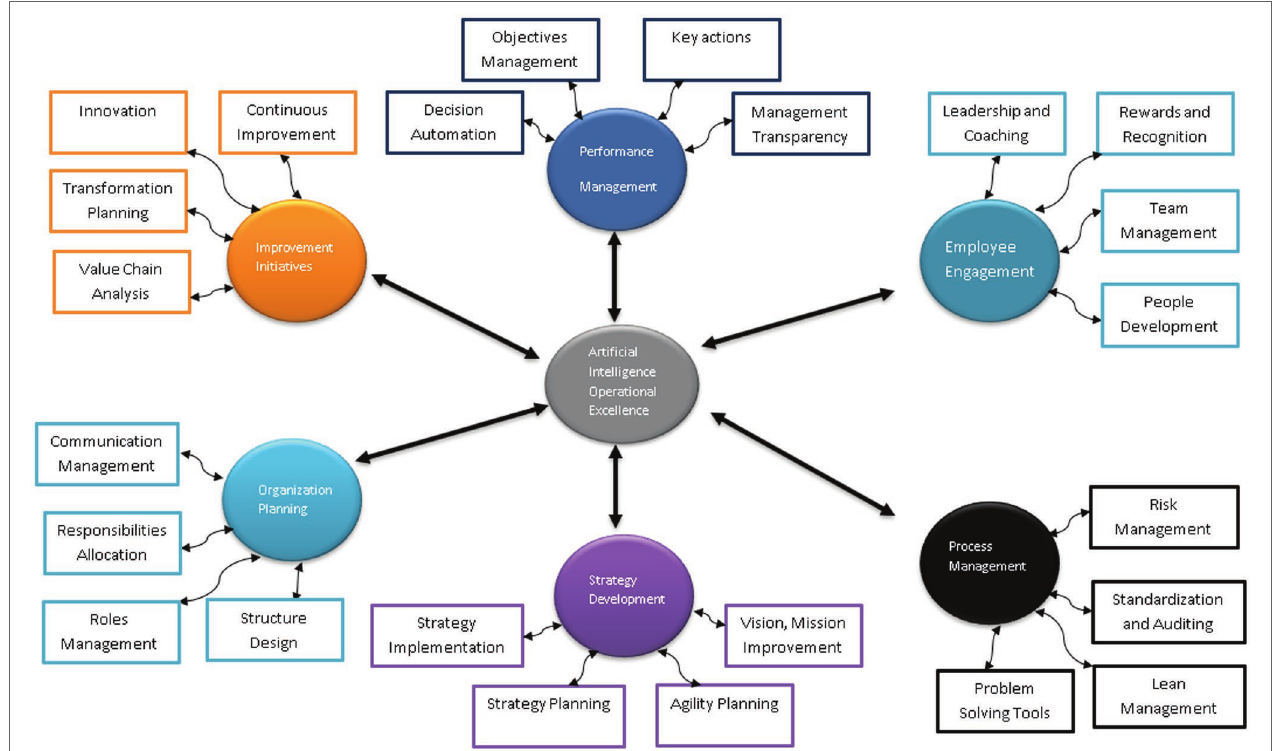
FIGURE 2 | Artificial intelligence-based operational excellence